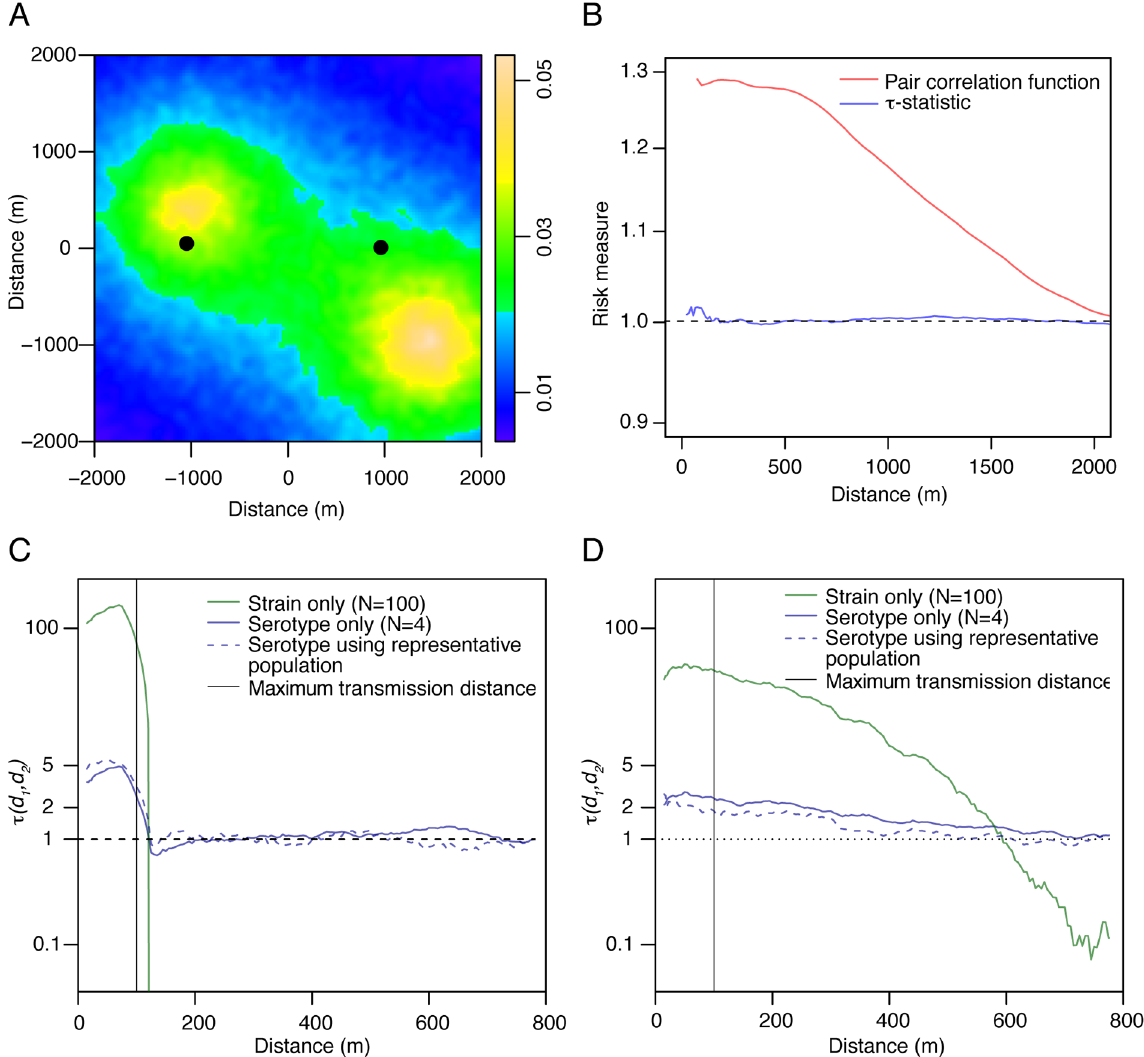
Fig 2. Overview of simulated epidemics of 100 separate transmission chains. Each transmission chain consisted of cases caused by a single strain, with all strains divided into four serotypes. (A) Distribution of underlying population for simulated data. The black square represents the area of analysis to avoid edge effects from the simulation process. The two black dots represent two ‘ surveillance hospitals ’ (relevant for the spatially-biased observation scenario set out in Fig 3). (B) Using disease type information (blue) allow the τ -statistic to correctly show no spatial clustering of disease in a spatially clustered population, whereas the pair correlation function would falsely indicate clustering in disease cases. (C) τ -statistic results from simulated epidemics where the cases infected individuals between 0 and 100m away. Each case infected one individual (effective reproductive number of one). (D) As (C) but each case infects two individuals (effective reproductive number of